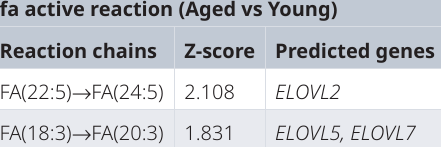
Table 2. BioPAN predicted genes for fatty acid active reactions in liver of aged vs young mice. Table contains the active reaction chains found by BioPAN according to the Z-score values. Several genes are predicted as being involved in the current status of each reaction based on their function. Pathway options: aged condition of interest, young control condition, fatty acid type, active status, p value 0.05, no